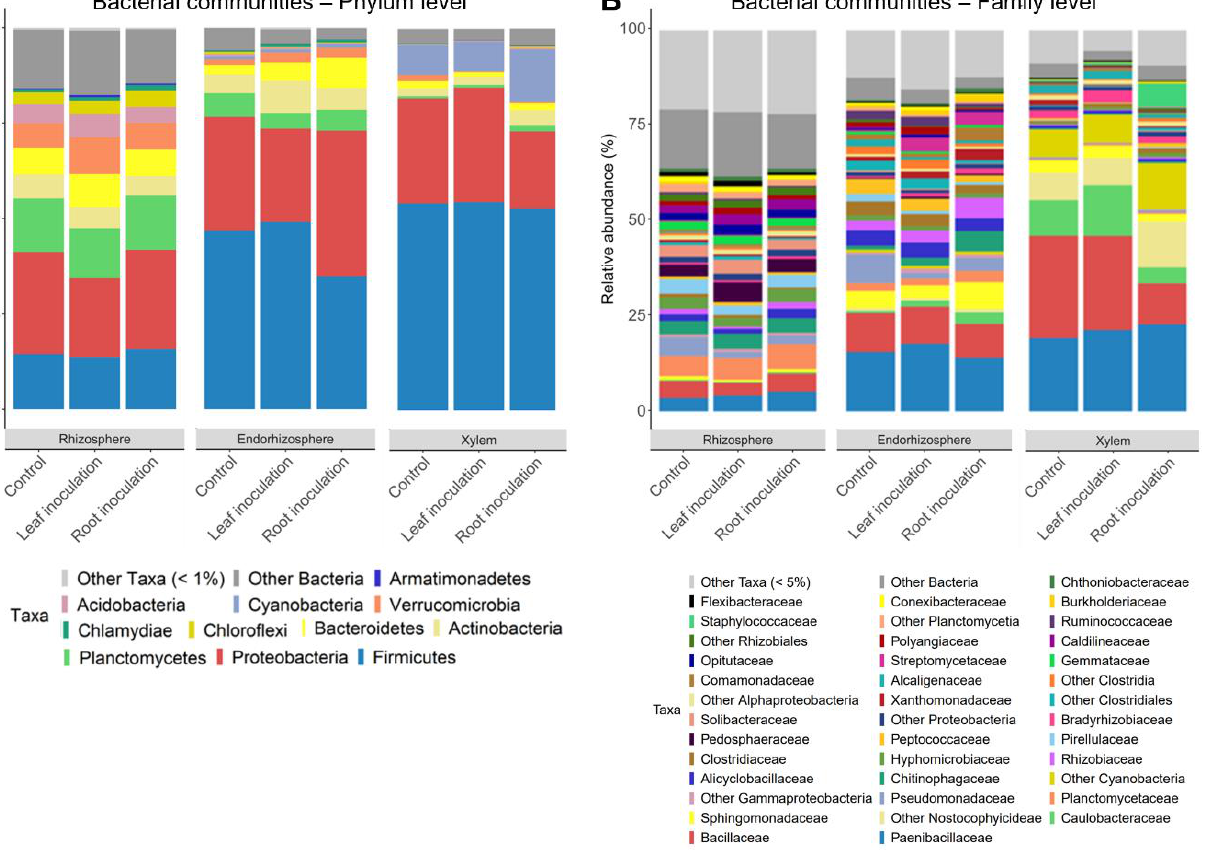
Figure 2. Relative abundances of the bacterial communities at the phylum ( A ) and family ( B ) taxo- nomic levels in the rhizosphere, endorhizosphere, and xylem compartments of control (non-inocu- lated) and inoculated (through leaves or roots) sour orange seedlings. Bacterial phyla and family taxa less abundant than 1% and 5%, respectively, are reported as “Other Taxa”.